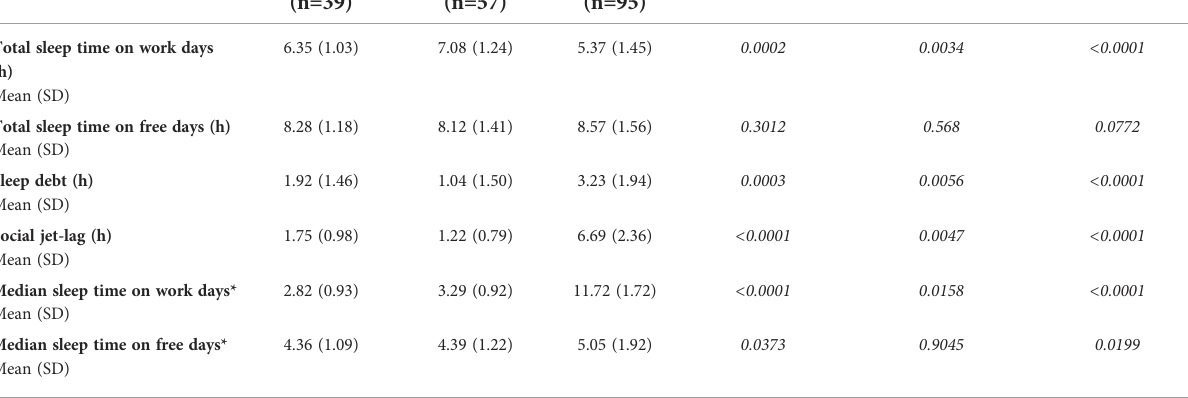
TABLE 2 Total sleep time, sleep debt and social jet-lag by type of shift and two-by-two comparisons of